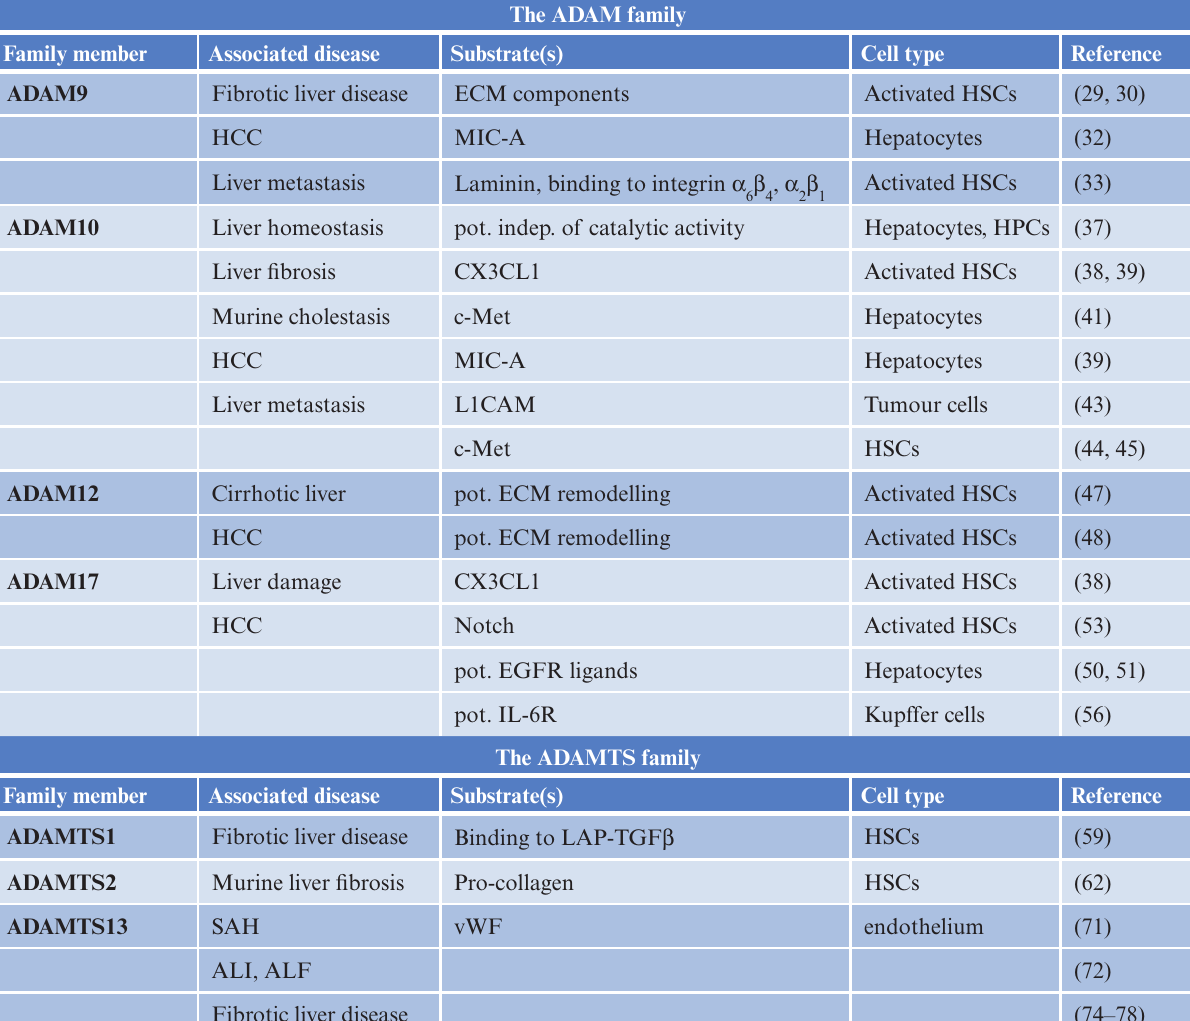
Table 1. Overview of known ADAM and ADAMTS proteinase activities in the liver and their association with hepatic